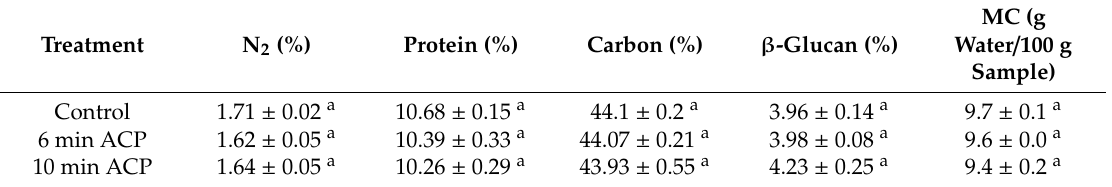
Table 6. E ff ect of ACP treatment on quality parameters of barley